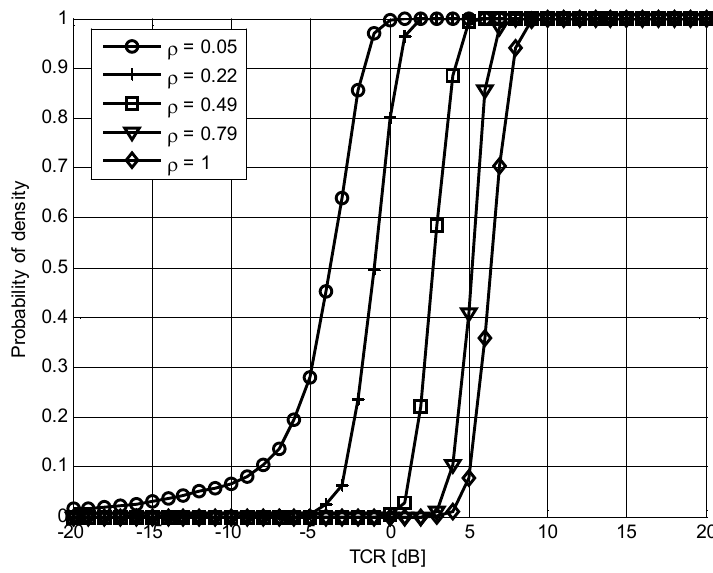
Figure 9. The probability of detection of the proposed approach for several coherence values when P FA = 10 − 4 and α =